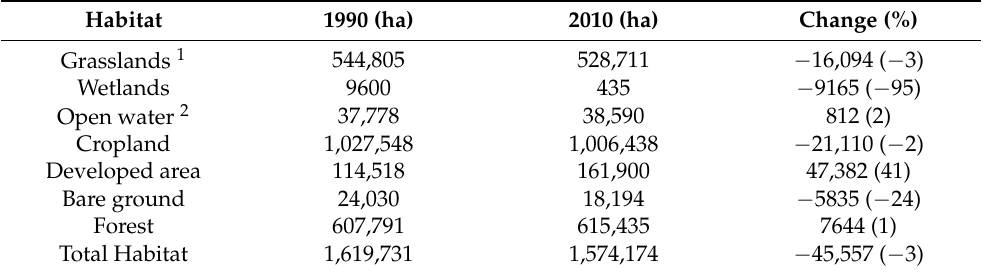
Table 7. Landcover change within the early migratory corridor north of Bohai.